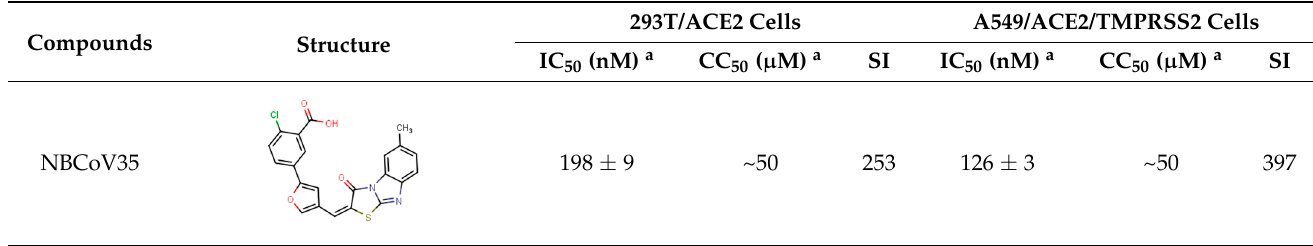
Table 1. Screening of the neutralization activity of NBCoV compounds against NL4-3 Δ Env - NanoLuc/SARS-CoV-2 (USA-WA1/2020) pseudovirus (IC 50 ), toxicity evaluation (CC 50 ), and selectivity indexes (SI) in two cell lines.